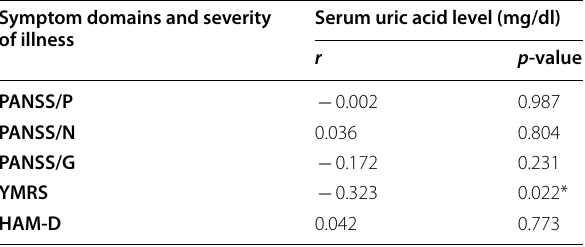
YMRS Young mania rating score. PANSS Positive and negative syndrome scale, PANSS/P Positive scale, PANSS/N Negative scale, PANSS/G general scale. HAM-D Hamilton depression scale, SD Standard deviation